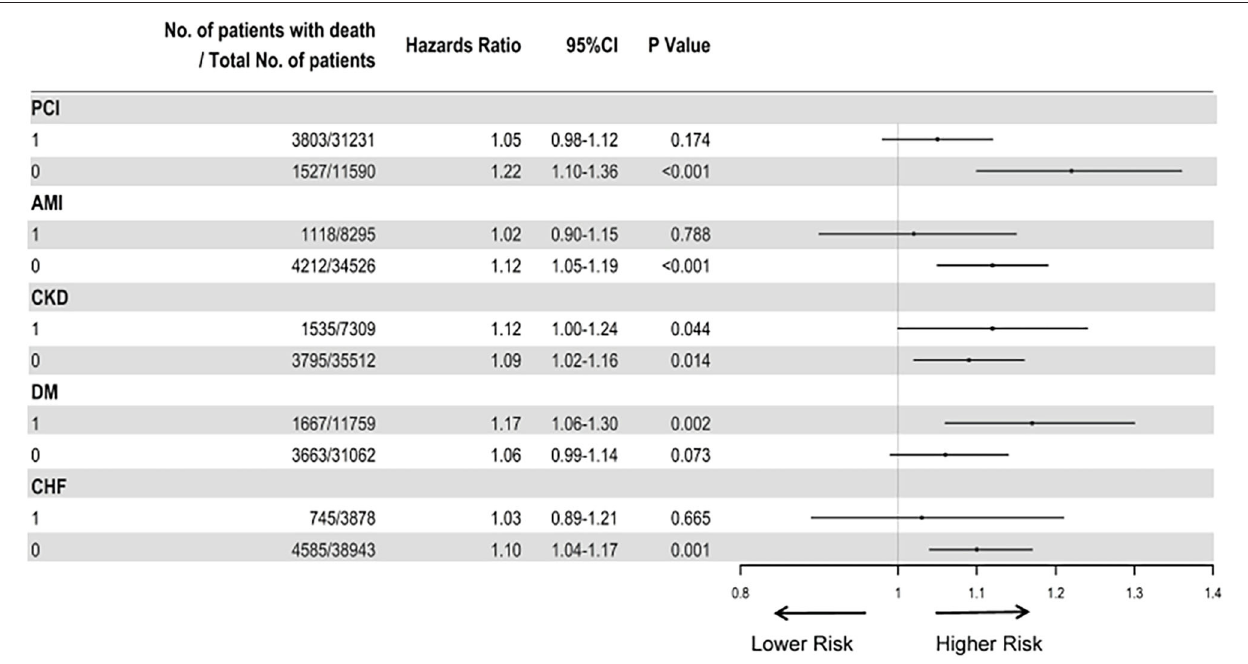
FIGURE 4 | Cox proportional hazard ratios for long-term all-cause mortality in different subgroups. The analysis in different subgroups was adjusted for age, gender, hypertension, acute myocardial infraction, diabetes mellitus, percutaneous coronary intervention, hemoglobin, white blood cell, congestive heart failure, total cholesterol, triglyceride, apolipoprotein A, low-density lipoprotein cholesterol, high-density lipoprotein cholesterol, chronic kidney disease, angiotensin-converting enzyme inhibitor/angiotensin receptor blockers, β -blockers, and